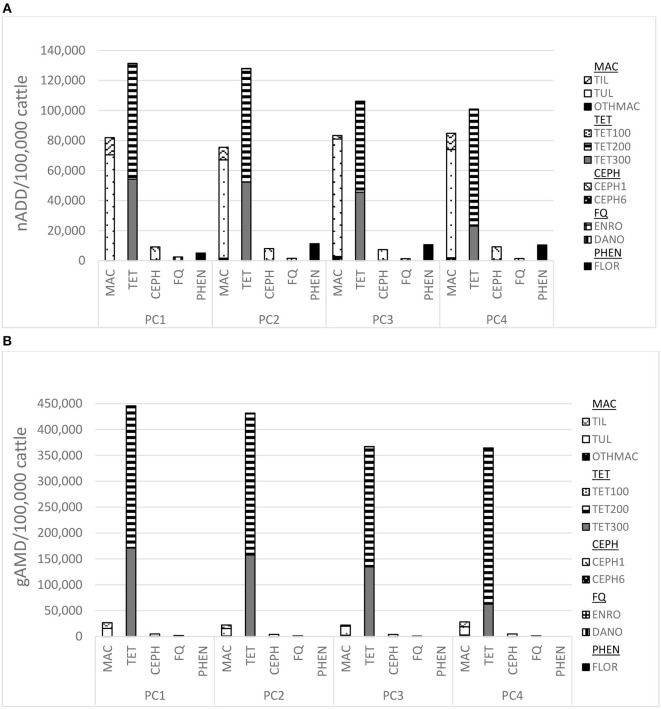
(A) Individually dosed antimicrobial drug use in nADD/100,000 cattle by placement cohort (PC)a, antimicrobial classb, and specific type of antimicrobial drugc, cattle placed 2008–2012. (B) Individually dosed antimicrobial drug (AMD) use in grams AMD (gAMD)/100,000 cattle by placement cohort (PC)a, antimicrobial classb, and specific type of antimicrobial drugc, cattle placed 2008–2012. aPlacement cohort comprised of cattle placed in the feedlot between 1 November and 31 October of consecutive years. bMAC, macrolides; TET, tetracyclines; CEPH, third generation cephalosporins; FQ, fluoroquinolones; PHEN, phenicols (TMS, trimethoprim-sulfamethoxazole; PEN, penicillin; SULF, sulfonamides not depicted due to low usage; cTIL, tilmicosin 10 mg/kg; TUL, tulathromycin 2.5 mg/kg; OTHMAC, gamithromycin 6 mg/kg, tildipirosin 4 mg/kg, tylosin 29 mg/head; TET100, oxytetracycline 6.67 mg/kg; TET200, oxytetracycline 20 mg/kg; TET300, oxytetracycline 30 mg/kg; CEF1, ceftiofur hydrochloride or sodium, 1.1 mg/kg; CEF6, ceftiofur crystalline free acid 6.6 mg/kg; DANO, danofloxacin 6 mg/kg; ENRO, enrofloxacin 7.7 mg/kg; FLOR, florfenicol 40 mg/kg.